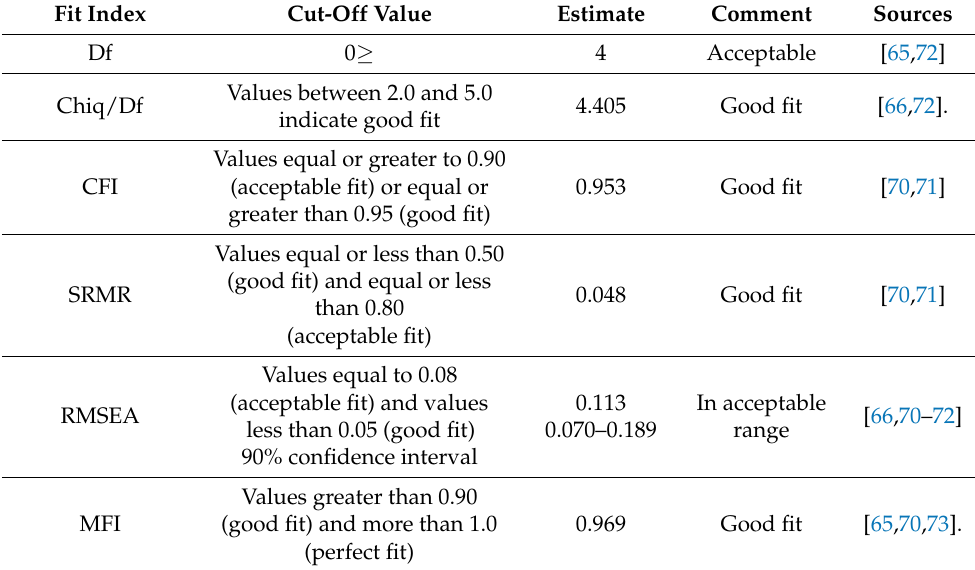
Table 12. Robust fit indexes for path